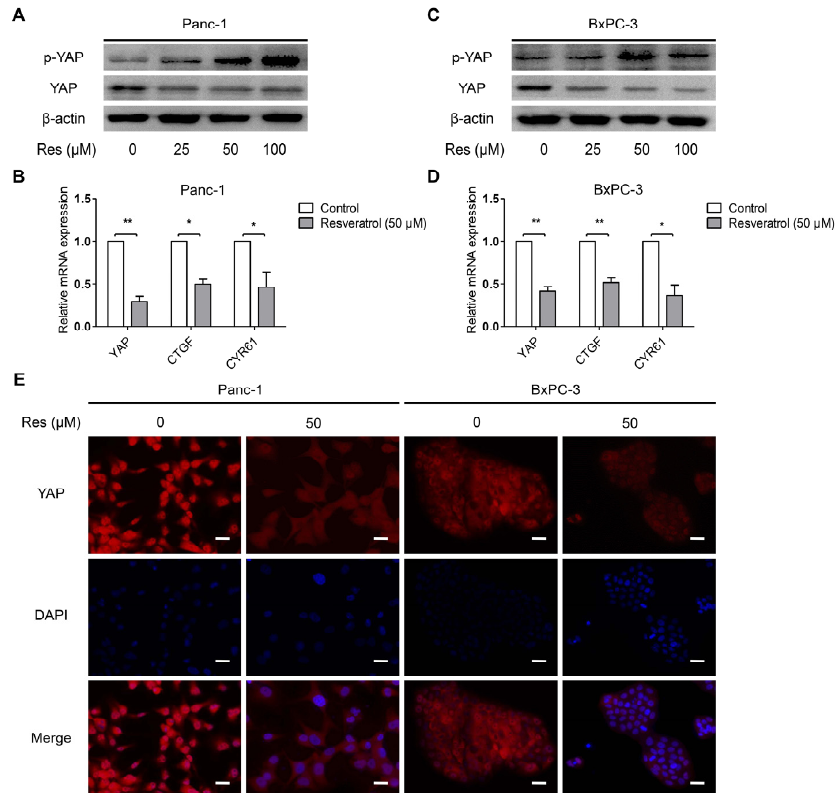
Figure 3. Resveratrol inhibits YAP expression of pancreatic cancer cells. ( A , B ) The effects of resveratrol on the protein expression of YAP and p-YAP (Ser127) were examined by Western blot analysis using β -actin as an internal loading control; ( C , D ) The effects of resveratrol on the mRNA expression of YAP, connective tissue growth factor (CTGF) and CYR61 were examined by real-time PCR with β -actin as the normalized reference gene. The data represent the results of three independent experiments; ( E ) Immunofluorescence staining of YAP in Panc-1 and BxPC-3 cells after treatment with resveratrol (50 µ M) for 24 h. YAP staining is shown in red, and nuclear DNA staining by DAPI is shown in blue. (Magnification, 400 × ; Scale bar: 20 µ m). Column: mean, bar: SD, * p < 0.05, ** p < 0.01.